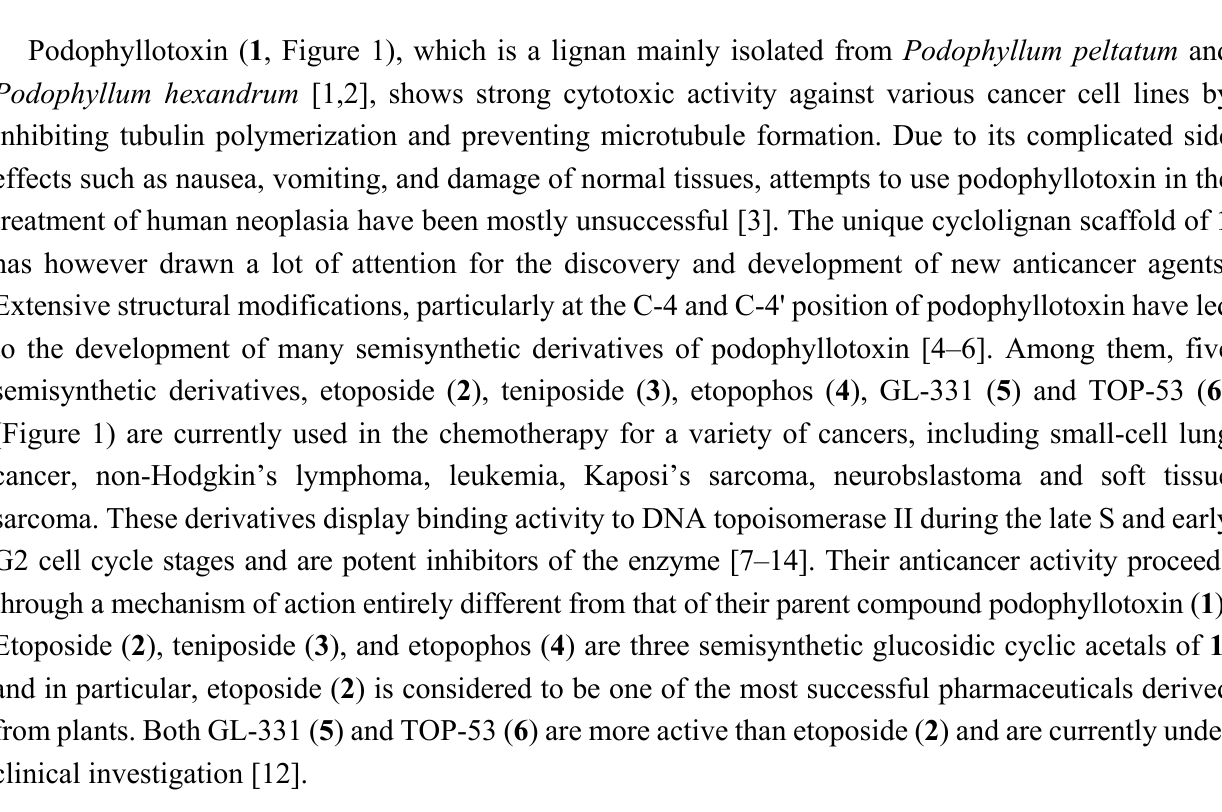
Figure 1. Structures of podophyllotoxin ( 1 ) and its semisynthetic